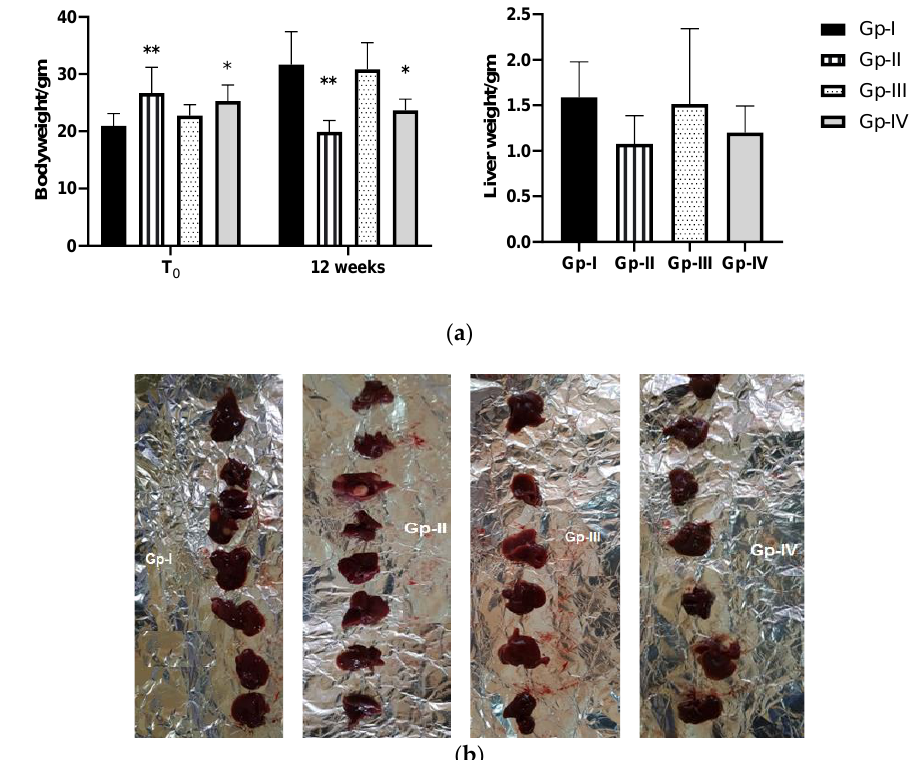
Figure 3. ( a ) Effect of A. gigantea leaf defatted methanolic extract on body weight (at initial time and 12 weeks) and liver weight (at 12 weeks) of different mouse groups. Gp-I: Group I, normal group; Gp-II: Group II, treated with DEN; Gp-III: Group III, treated with A. gigantea ; Gp-IV: Group IV, treated with DEN combined with plant extract. Data represent the mean ± SEM. * p < 0.05, ** p < 0.01 indicate significant differences compared to Gp-I. ( b ) This photo represents liver mass between different groups.